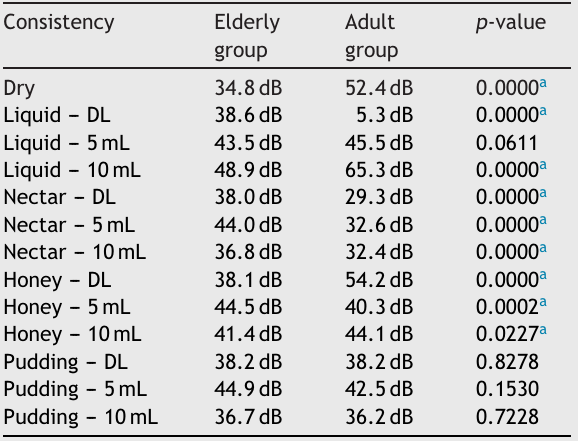
Comparison between elderly (GI) and adult (GII) groups for initial intensity